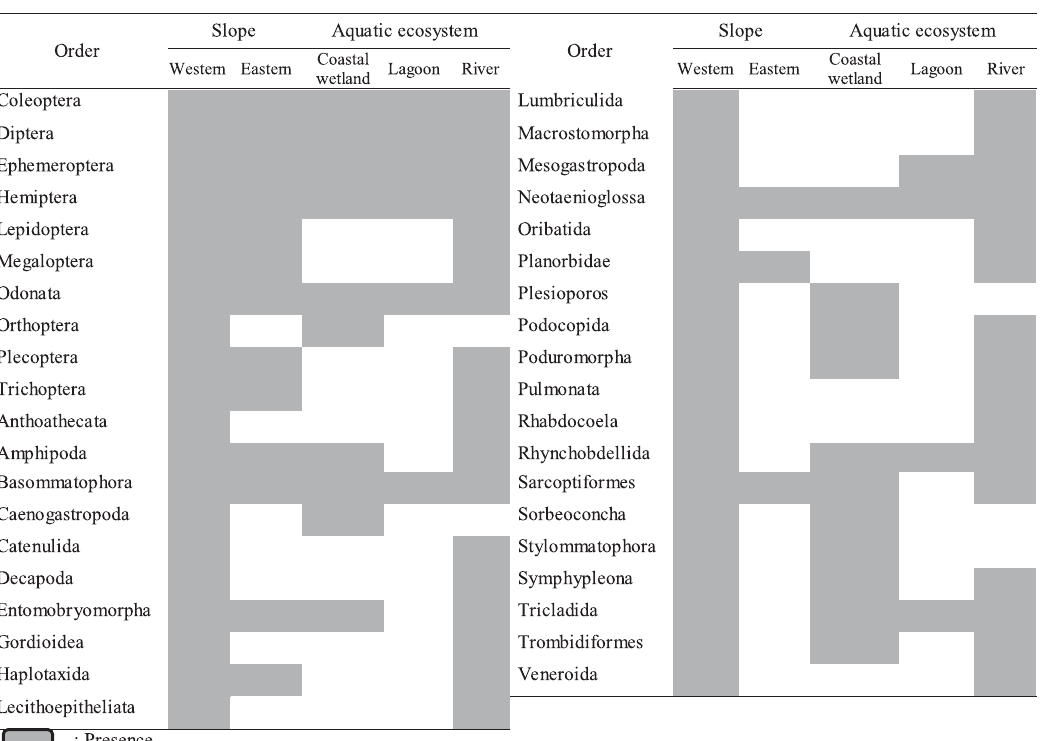
Frontiers in Environmental Science |